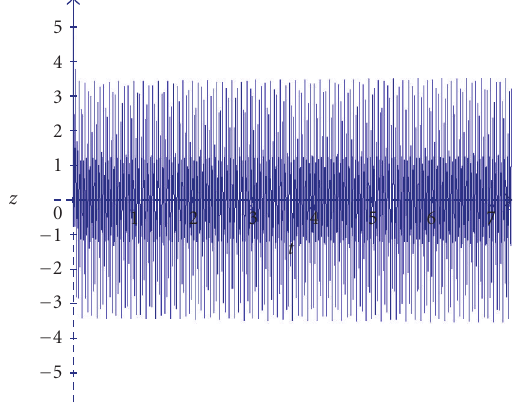
Figure 6.8 . Bounded solution of (5.2) in the point K (279 . 9,150), a 0 = 6.